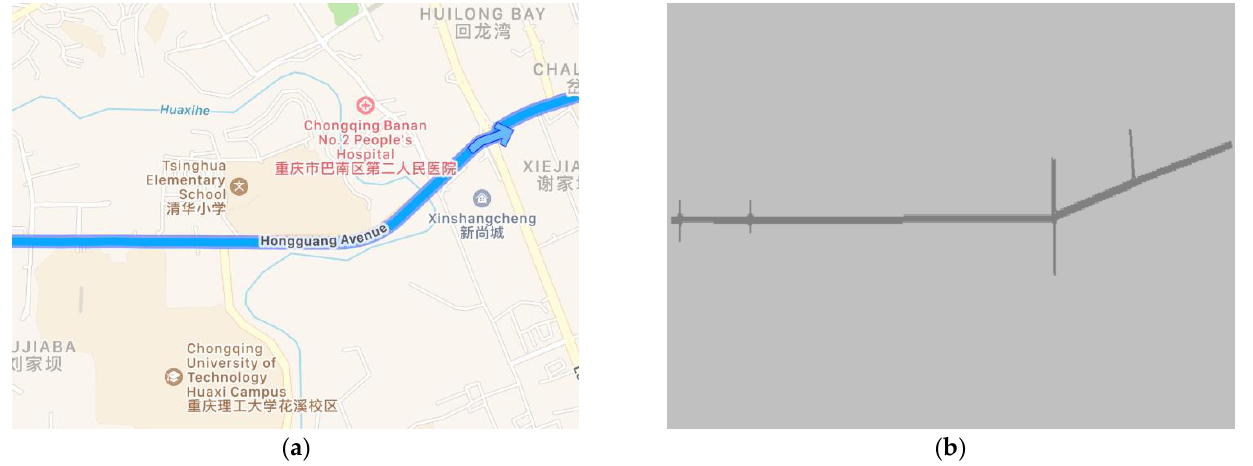
Figure 15. Test road: ( a ) Test road under high precision map; ( b ) Test road under VISSIM scene modeling.